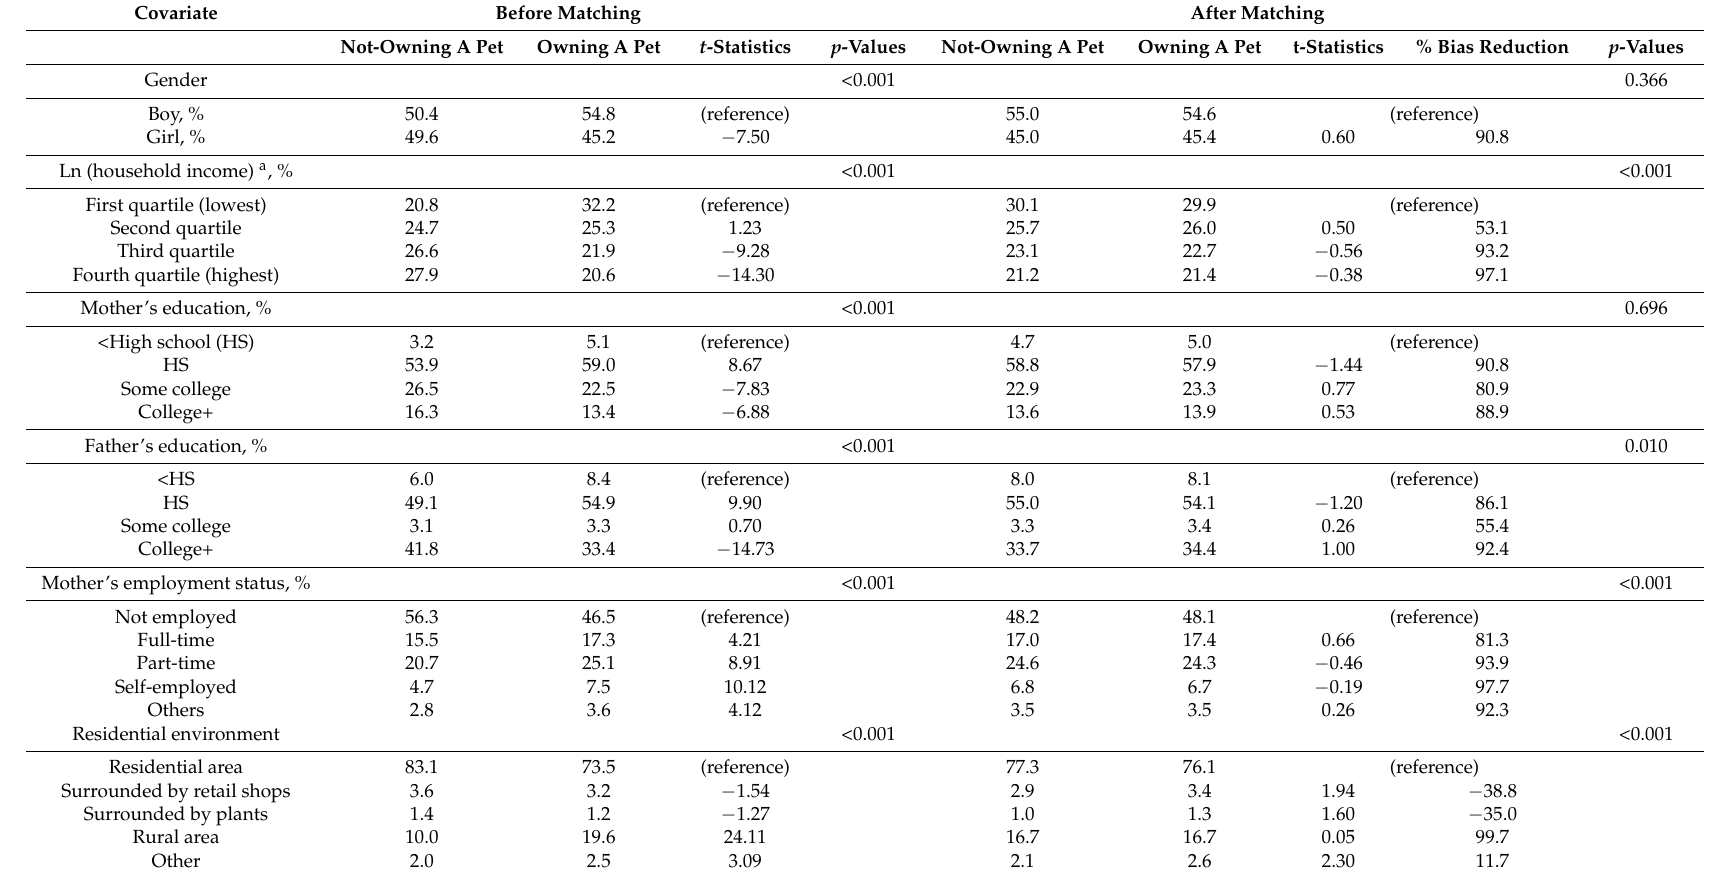
Table 3. Distribution of covariates by employment condition before and after